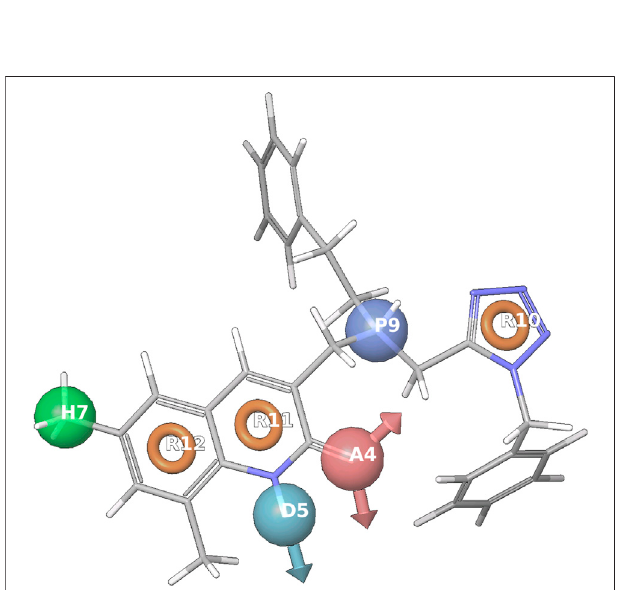
FIGURE7| Representsthecommonpharmacophorehypothesesusing screened ligand and Known Compounds, where R10 has the most important common pharmacophoric feature that inhibits